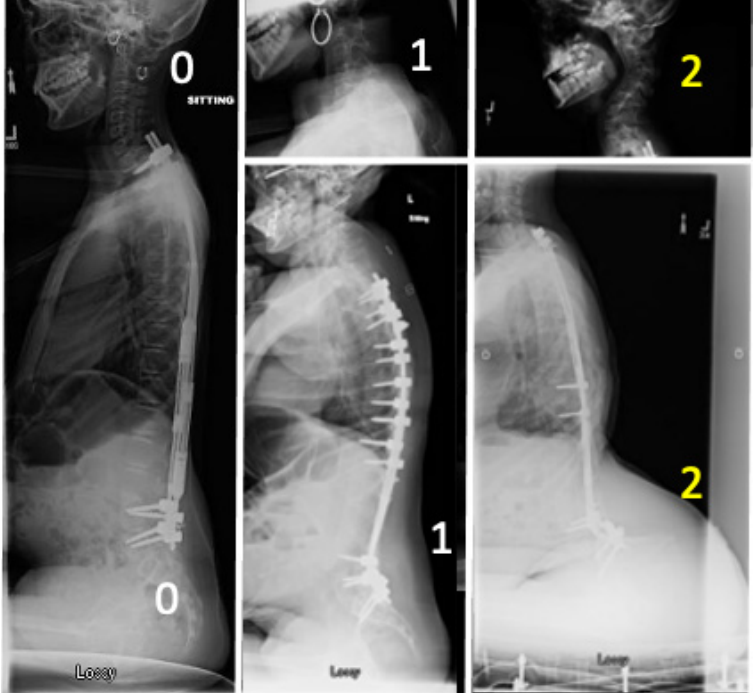
Figure 2. Examples of scoring the latest available radiographs in this study. ( Left ) Normal (0,0) scoring of no tucked chin or trunk tip. ( Middle ) Transitional scores of 1 for slight visual tucked chin (top) and prominent buttock (bottom). ( Right ) Obvious tucked chin (top) and tipped trunk (bottom) scoring a 2 in our system. Only those scoring a 2 (denoted in yellow) were included in our Deformity Cohort, these were compared against those scoring 0 or 1 (white)